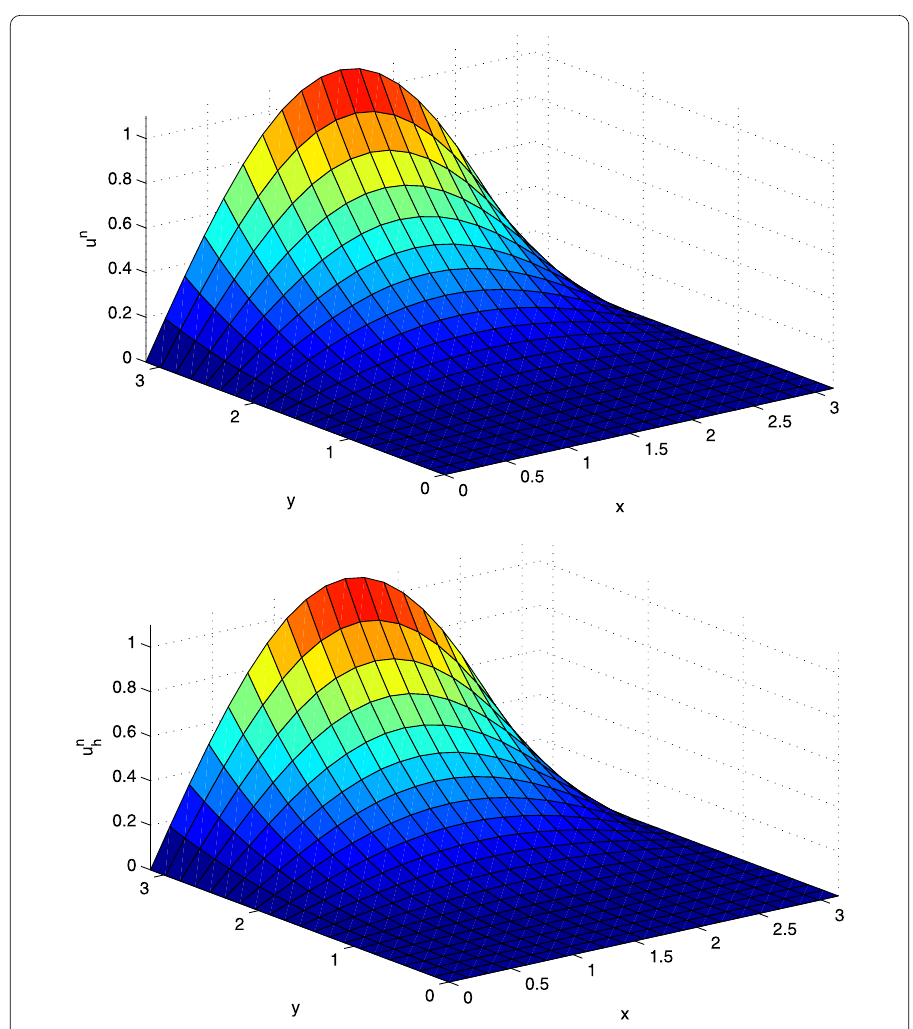
Figure 1 The exact solution (top) and numerical solution (bottom) for Example 1, when h = 0.05, τ = 0.05, α = 0.5 and T =